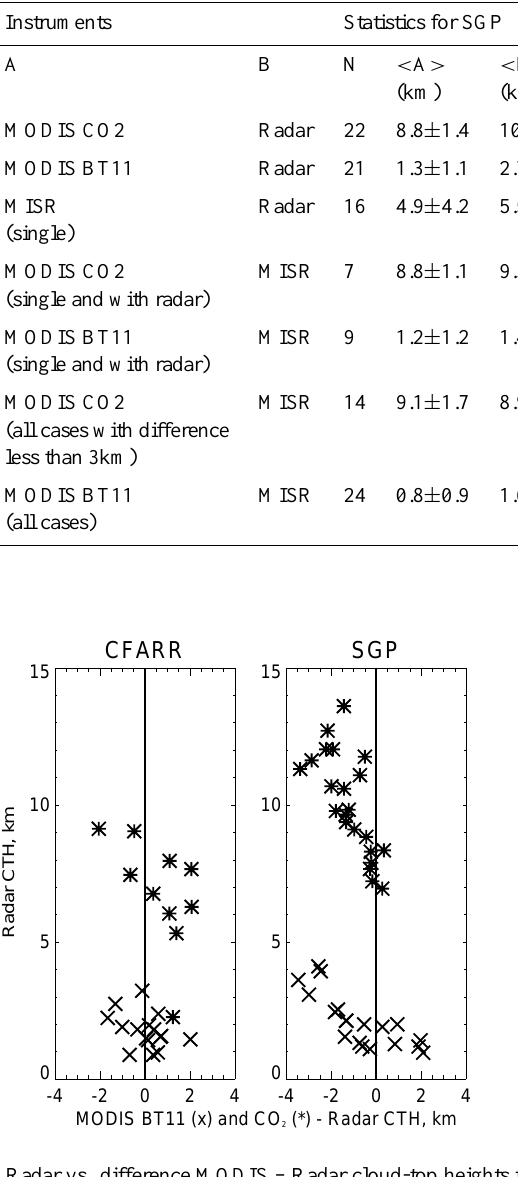
Fig. 4. Radar vs. difference MODIS – Radar cloud-top heights for CFARR (left) and SGP (right) distinguishing between BT11 cases (x) and CO 2 -slicing cases